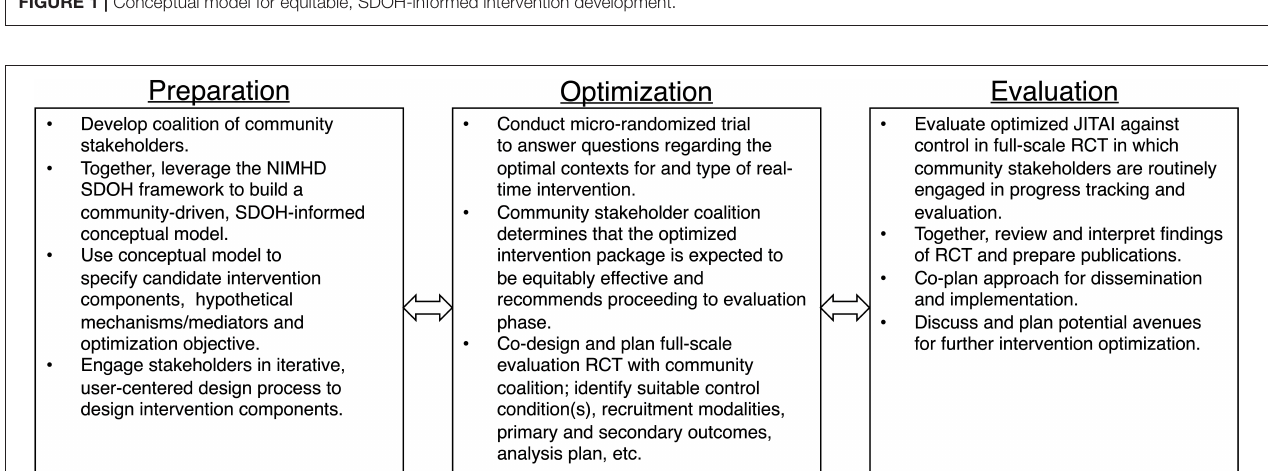
FIGURE 1 | Conceptual model for equitable, SDOH-informed intervention development.